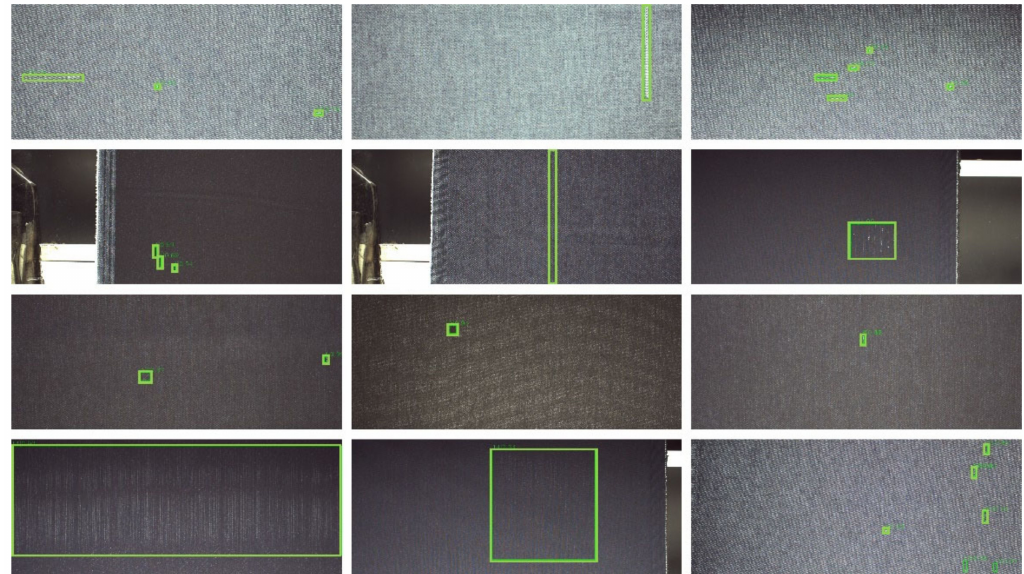
Figure 11. The detection results of PRAN-Net for the denim dataset.